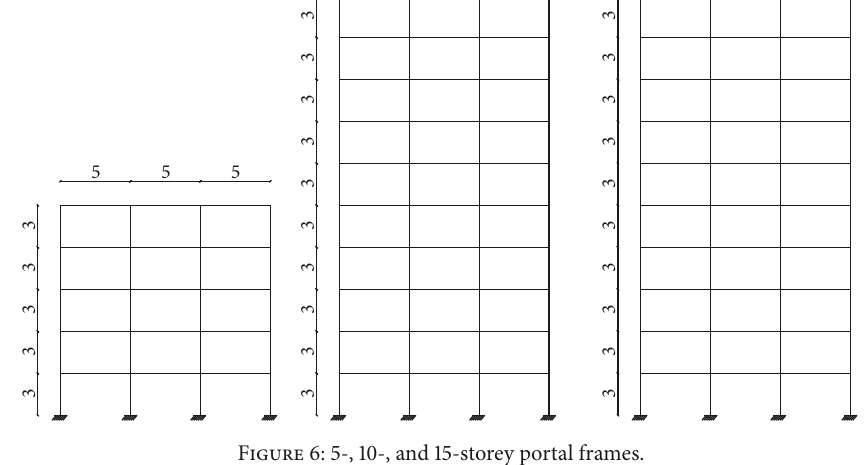
Figure 6: 5-, 10-, and 15-storey portal frames.